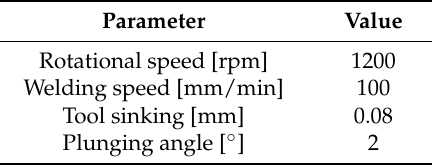
Table 3. Welding process